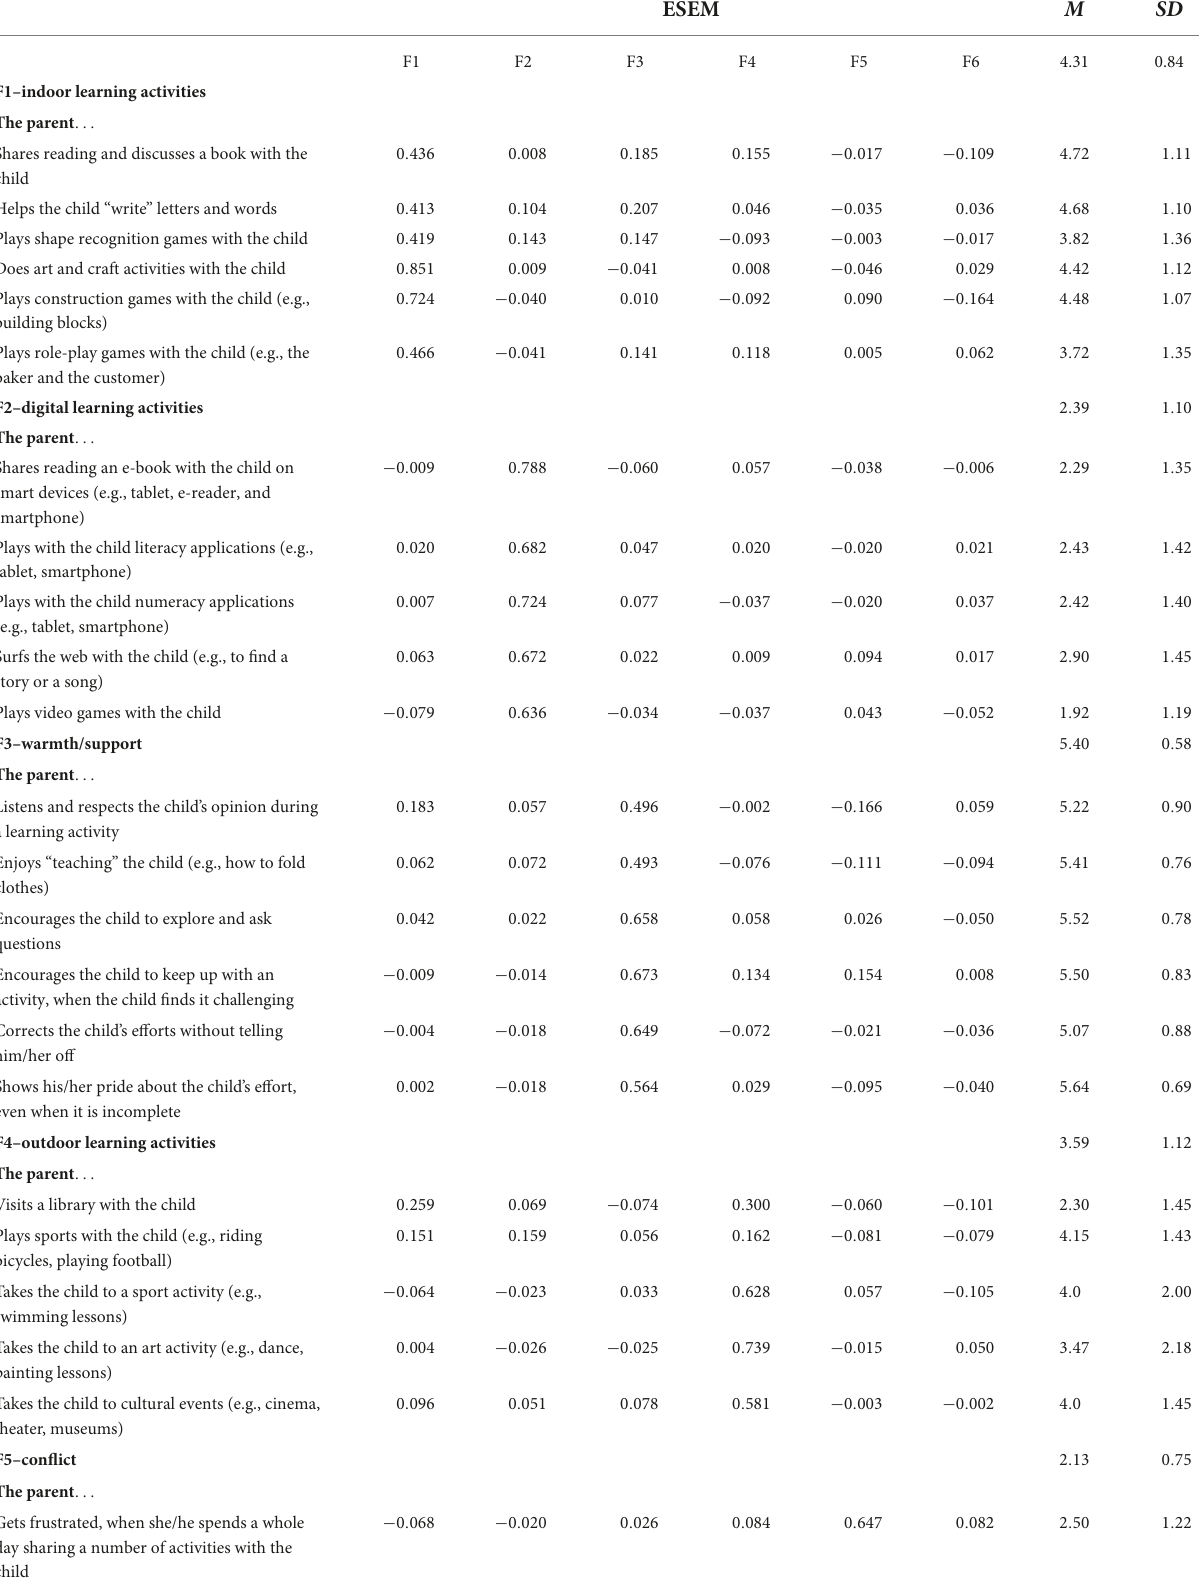
TABLE 1 Home learning environment questionnaire (HLEQ) items loadings for the exploratory structural equation modeling (ESEM) solution and descriptive